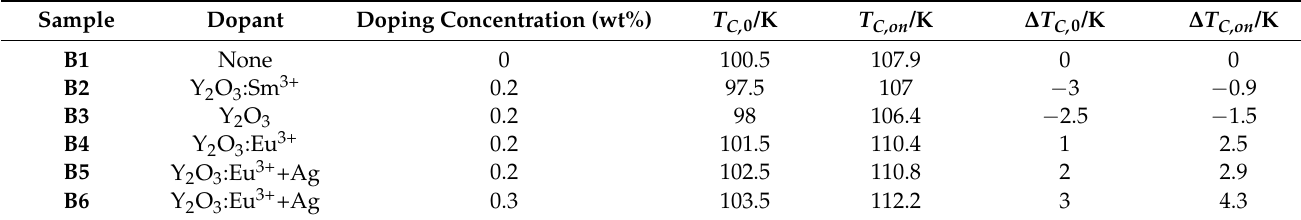
Table 2. Dopant, doping concentration, T C, 0 , and T C,on of B series samples prepared from raw material S2 (15 µ m). Sample